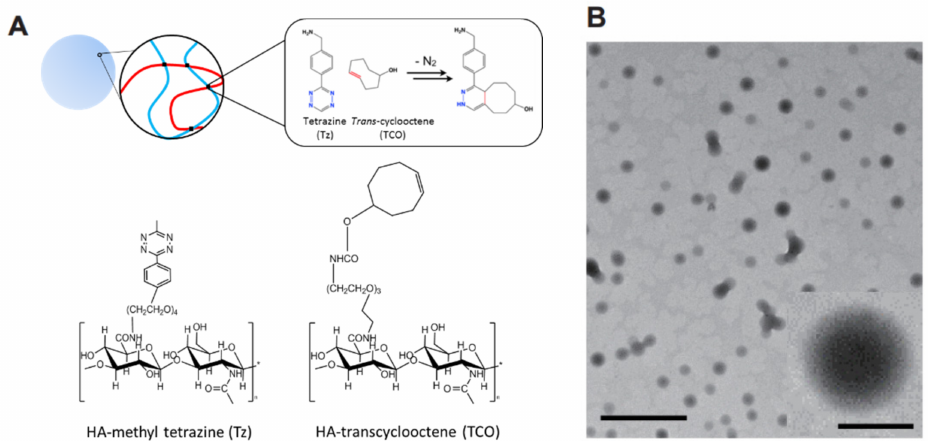
Figure 1. ( A ) Schematic illustration of HA nanogels crosslinked via click chemistry between methyl tetrazine (Tz) and trans -cyclooctene (TCO). ( B ) The Cryo-TEM image of HA nanogel (scale bar = 500 nm). Inset shows the expanded image of an individual nanogel particle (scale bar = 100 nm).